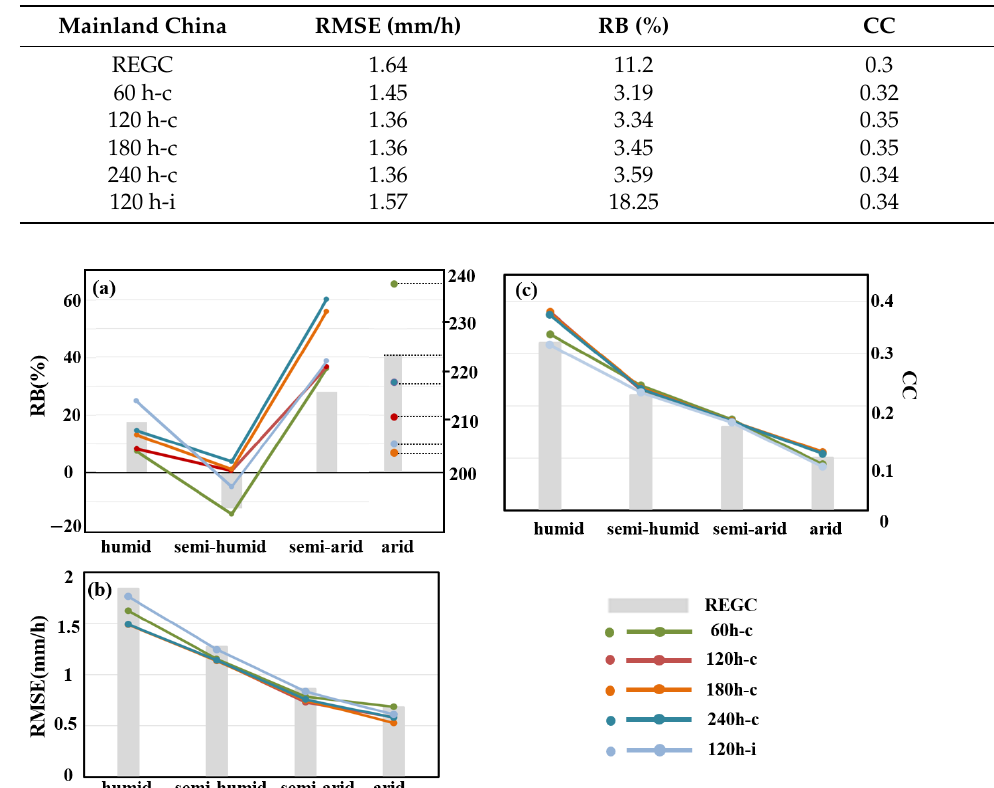
Table 3. Metrics of hourly SISP-RT against CMPA at gauged pixels in Mainland China under the different lengths of the training period.